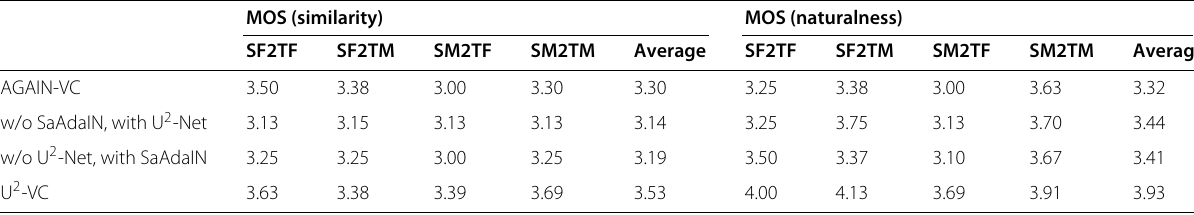
Table 4 Subjective evaluation results of the ablation study on architecture in seen-to-seen conversion scenario. “AGAIN-VC” represents the network has neither U 2 -Net structure nor SaAdaIN. “U 2 -VC” represents the network has both U 2 -Net structure and SaAdaIN MOS (similarity)